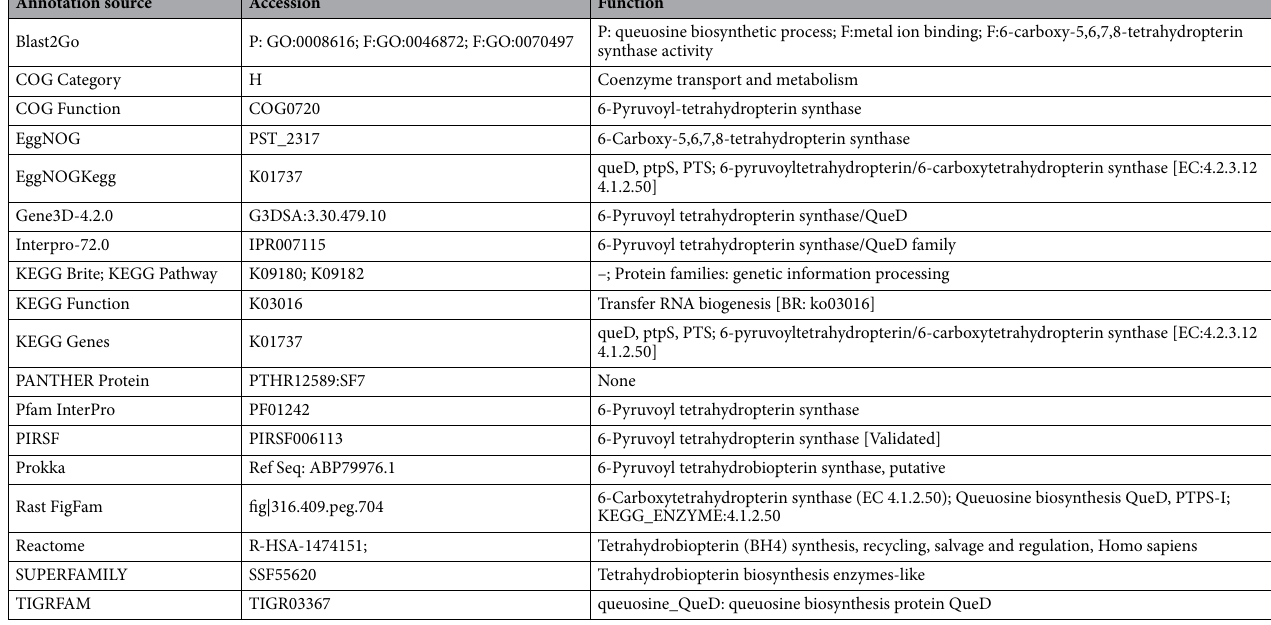
Table 2. Functional annotation of a CDS (yellow border in Fig. 3Β).